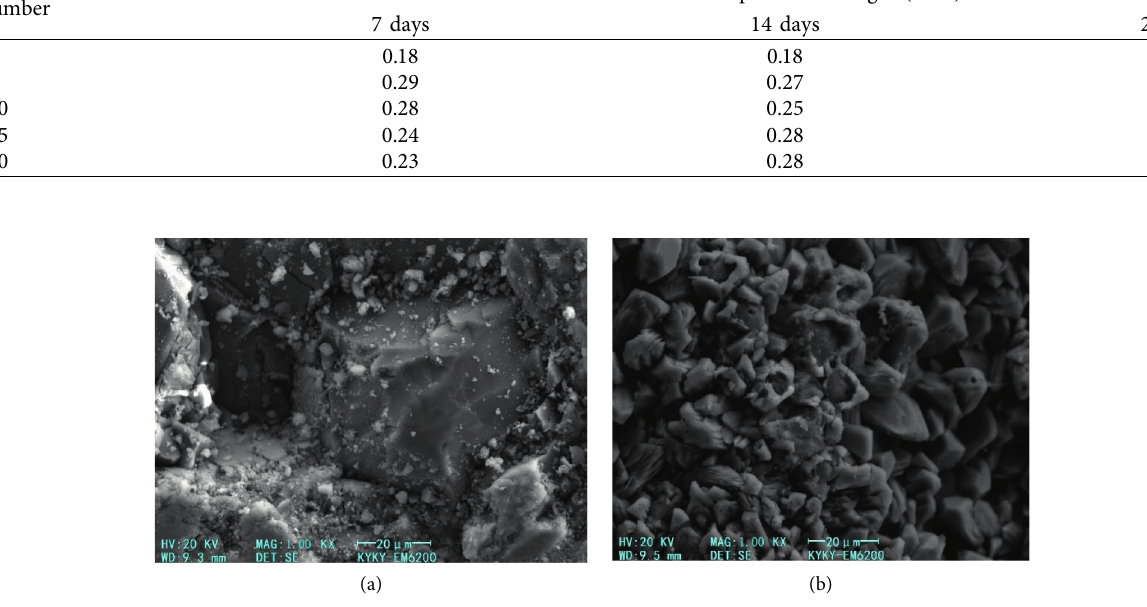
Figure 9: SEM pattern (a) without polyurethane and (b) with polyurethane.